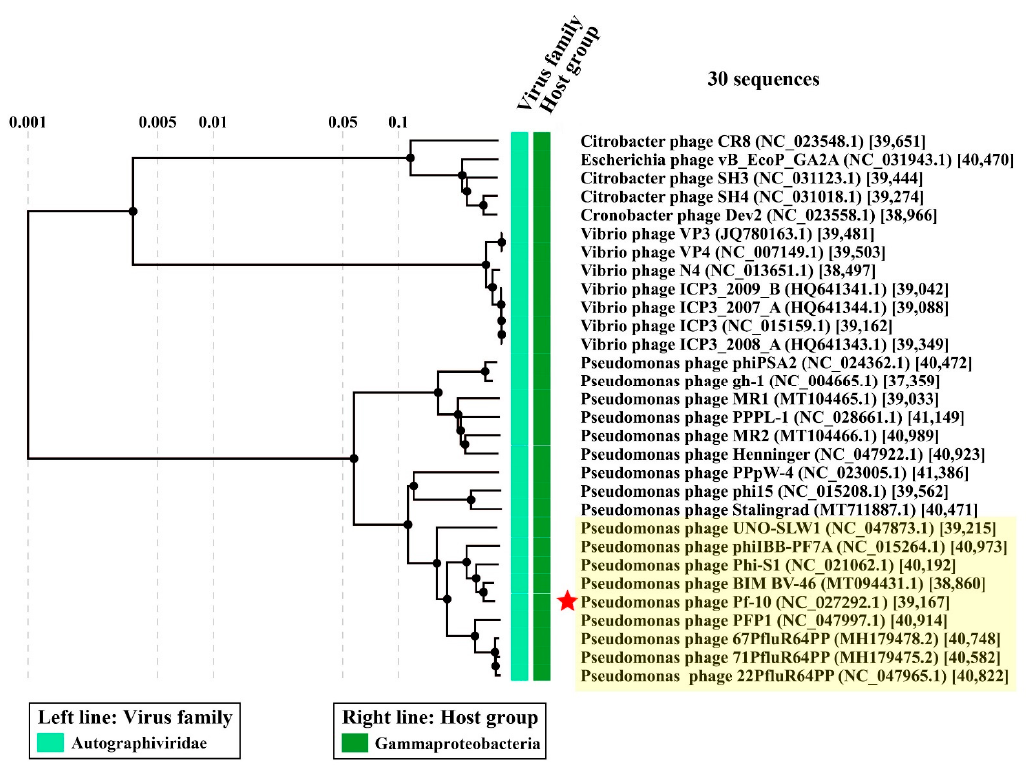
Figure 9. The viral proteomic tree including Pseudomonas phage Pf-10 and other most closely related phages constructed using the ViPTree server version 1.9. The red star represents the Pseudomonas phage Pf-10. The clade containing the genus Pifdecavirus phages is highlighted in light yellow.